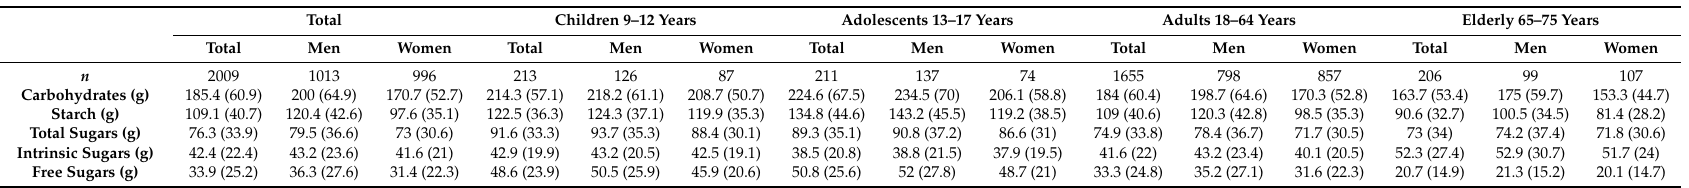
Table 3. Carbohydrates intake and distribution (g/day) by sex and age groups in the Spanish ANIBES Study